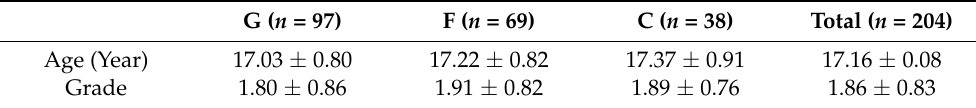
Table 1. General characteristics of players by their